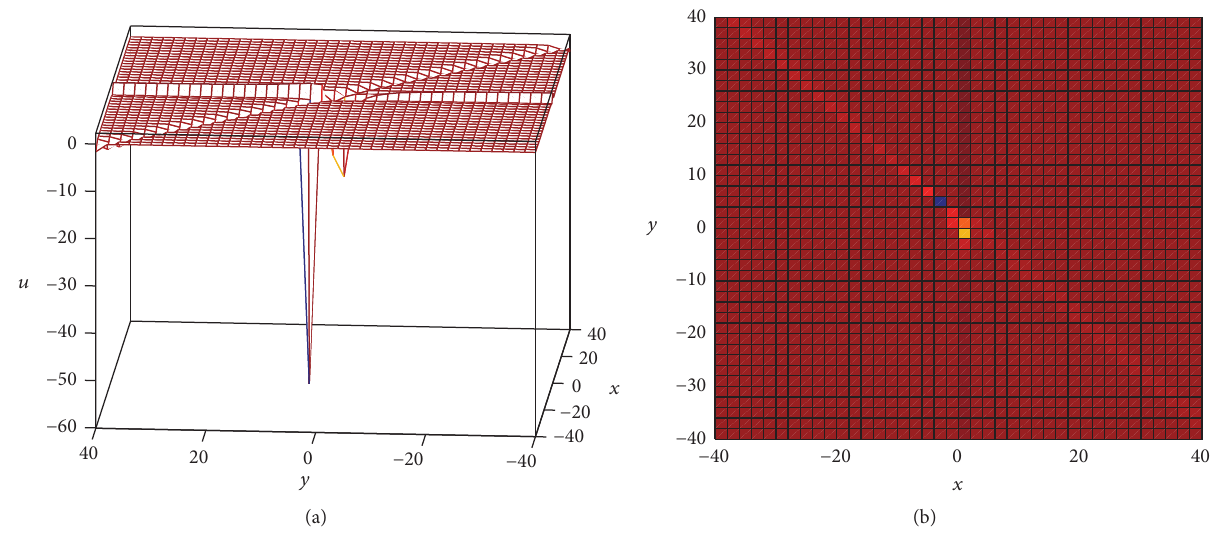
Figure 2: Pictures of (19): 3D plot (a) and density plot